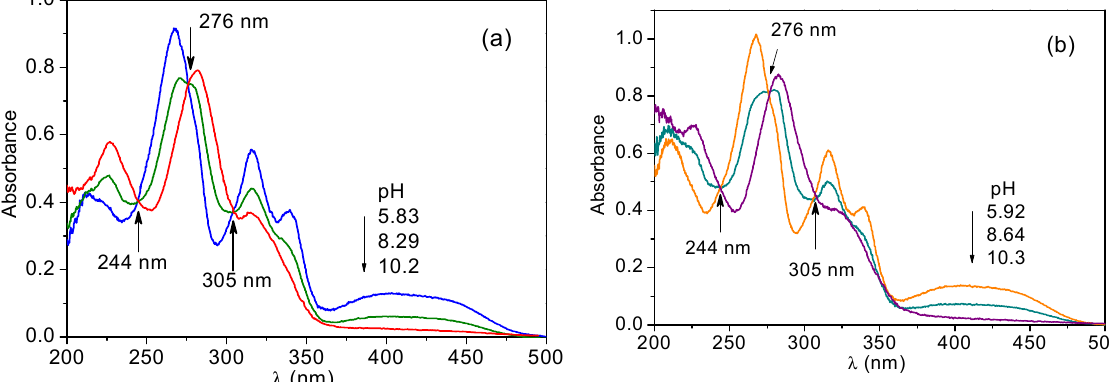
Figure 7. Absorption spectra of CH ( a ) and ECH ( b ) in aqueous solutions with different pH. c CH = 6.50 μ g·mL − 1 , c ECH = 7.95 μ g·mL − 1 . 3.6. Effect of pH Value on Fluorescence Intensity of CH and ECH in Aqueous Solutions Figure 8 is the excitation and emission spectra of CH and ECH in aqueous solutions at various pH values. The spectra of CH and ECH are very similar, which is consistent with the above discussion. In these spectra, the centers of λ ex and λ em locate at 279 nm and 406 nm, respectively, which is consistent with the 3D fluorescence spectra shown in Figure 6. Changing the pH value will result in the change in fluorescence intensity, but it has no effect on λ ex and λ em .